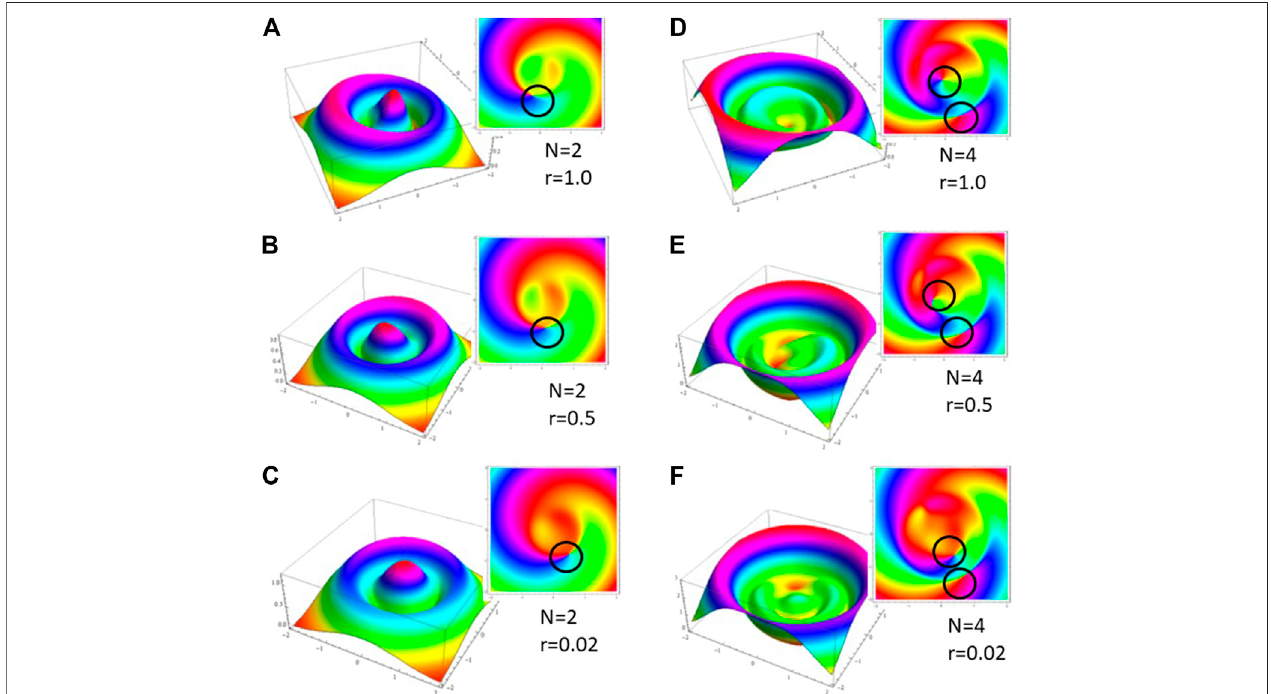
(cid:5)(cid:5)(cid:5)(cid:5) (cid:5)(cid:5)(cid:5)(cid:5) ( x , y ) ψ FIGURE2| 3Dplotsofamplitude forresultingLaguerre-Gaussmodeinthequadraturerepresentation,depictingtheimpactofthesqueezingparameter LG r on the formation of vortices, for different values of squeezing parameter r and total photon-number N . Insets correspond to phase pro fi les Laguerre-Gauss mode revealing vortices or singularities in the quadratures (not in the transverse pro fi le of the beam). (A) N (cid:3) 2, r (cid:3) 1, (B) N (cid:3) 2, r (cid:3) 0 . 5, (C) N (cid:3) 2, r (cid:3) 0 . 02, (D) N (cid:3) 4, r (cid:3) 1, (E) N (cid:3) 4, r (cid:3) 0 . 5, (F) N (cid:3) 4, r (cid:3) 0 . 02. As thesqueezingparameter decreases,the formationof N / 2vortices in thequadraturesbecomes apparent (see text for